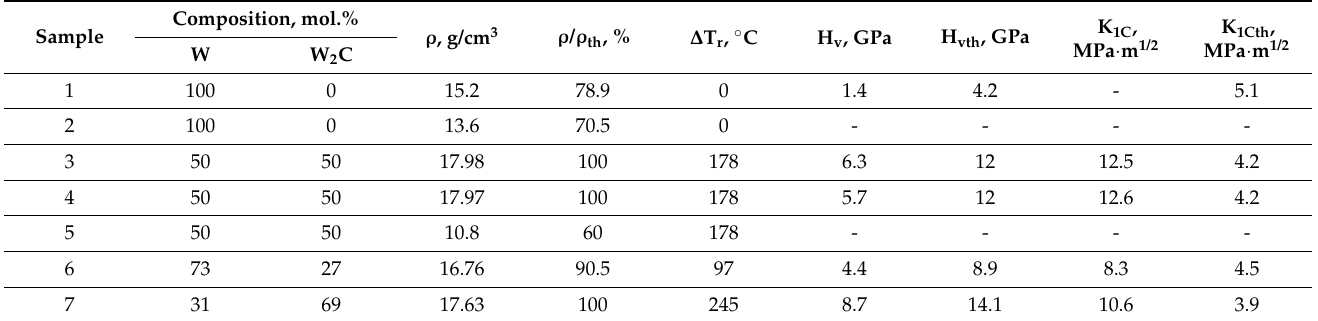
Table 2. The material’s final composition, density, adiabatic temperature rise ( ∆ T r ), and measured mechanical characteristics (H v , K 1C ). The theoretical values of Vickers hardness (H vth ) and toughness (K 1Cth ) were estimated with the rule of mixture.